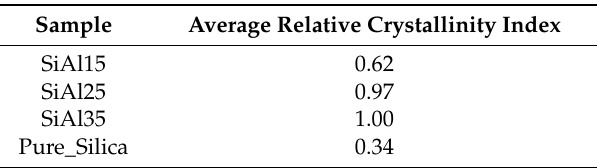
Table 2. Relative crystallinity index.